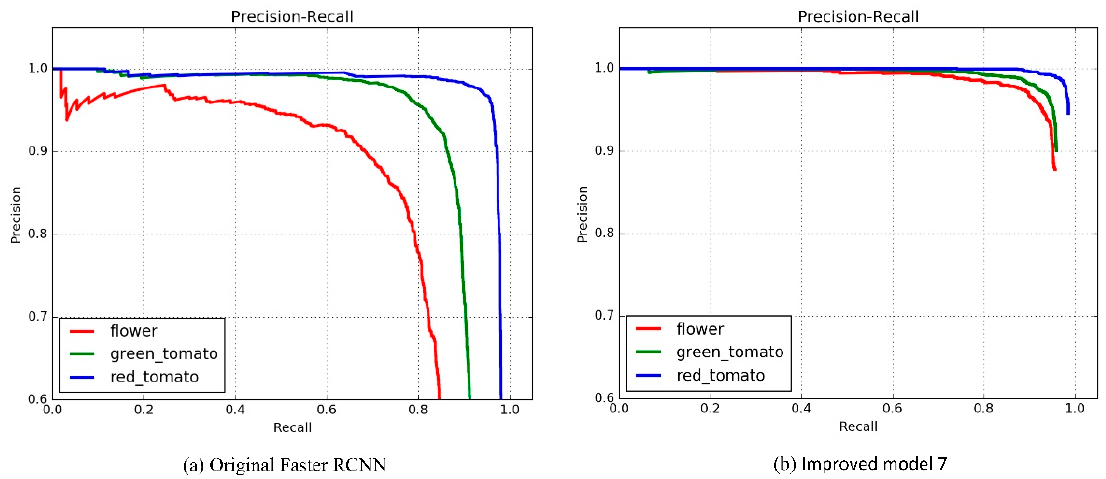
Figure 8. Precision and recall curve of the model. ( a ) Precision-recall curve of the original Faster R-CNN model; ( b ) Precision-recall curve of the improved model 7.